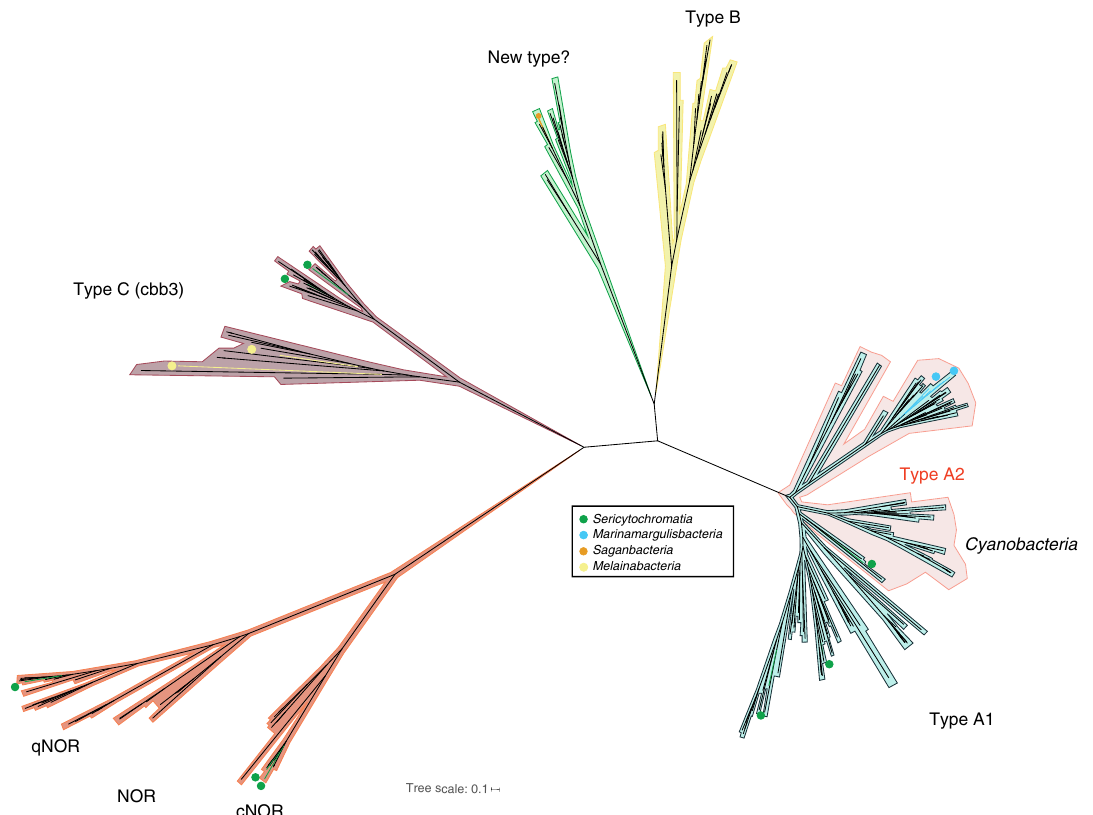
Fig. 7 Phylogenetic tree of the catalytic subunit I of heme-copper oxygen reductases. The heme-copper oxygen reductase found in Saganbacteria seems to be a novel type based on phylogenetic analysis of catalytic subunits (CoxA). Marinamargulisbacteria have an A2 type heme-copper oxygen reductase, which is usually found in Cyanobacteria. The enzyme in Marinamargulisbacteria is part of a separate phylogenetic cluster from the aa 3 -type heme-copper oxygen reductase found in Cyanobacteria (Supplementary Fig. 5). The heme-copper oxygen reductase found in Sericytochromatia LSPB_72 7 is type A1, and CBMW_12 has two enzymes 7 : one of type A1 and the other of type A2. Sericytochromatia LSPB_72 and CBMW_12 also have type C heme-copper oxygen reductases (CcoN) 7 , like Melainabacteria in this study. Two types of bacterial nitric oxide reductase (NOR) have been identi fi ed in Sericytochromatia. One is a cytochrome bc -type complex (cNOR) that receives electrons from soluble redox protein donors, whereas the other type (qNOR) lacks the cytochrome c component and uses quinol as the electron donor. The tree is available with full bootstrap values in Newick format in Supplementary Data